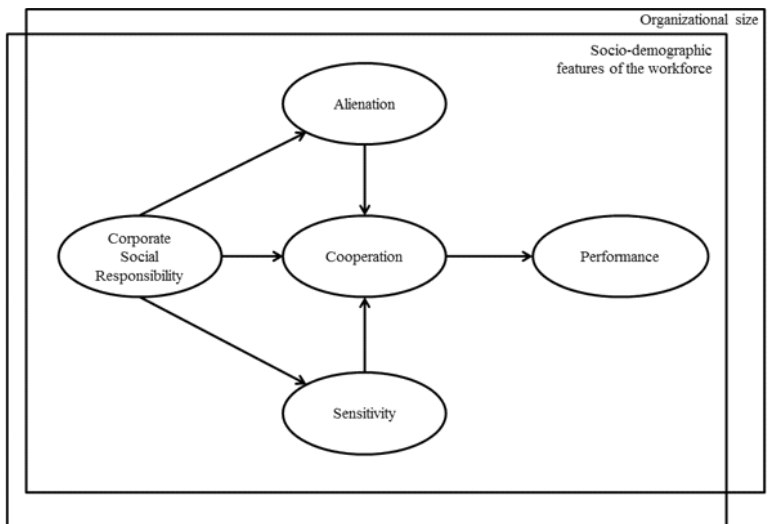
Fig. 4. SEM model: CSR as determinant of organizational